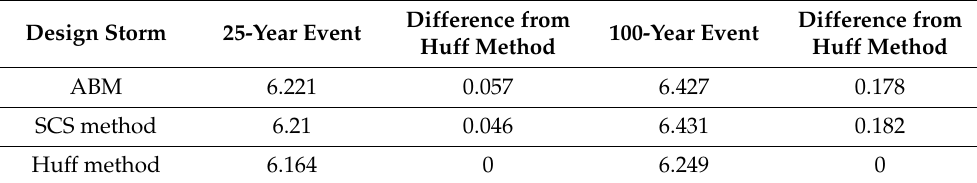
Table 3. Inundation area (square kilometers) for different design storms in the historical period.